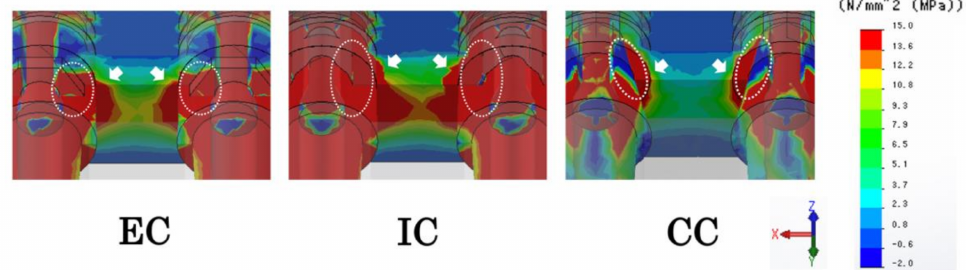
Figure 4. Maximum principal stress distribution of the bone and implant components at an inter- implant distance of 3.0 mm.